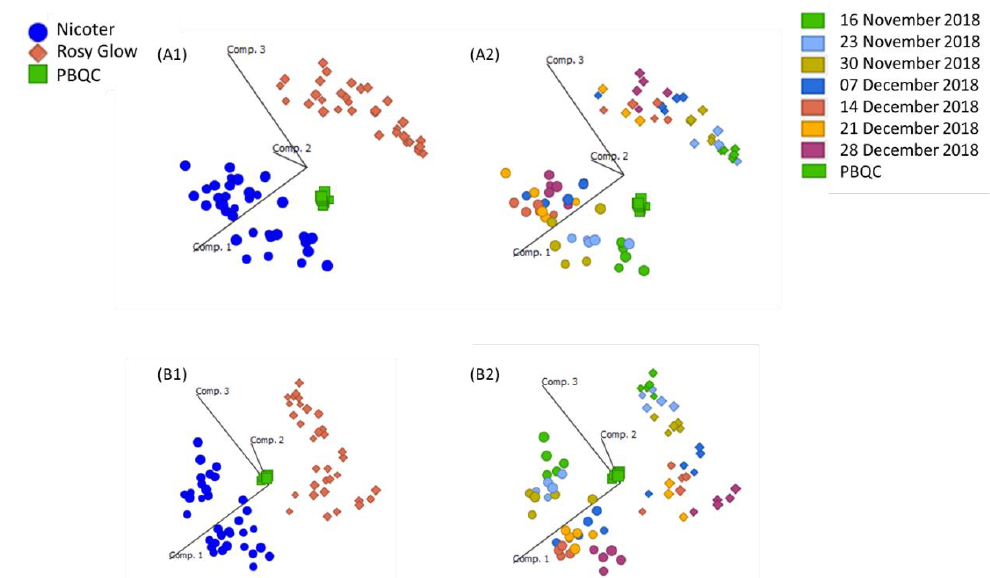
Figure 2. Principal component analysis (PCA) score plot showing ‘Nicoter’ ( n = 35) and ‘Rosy Glow’ ( n = 33) apple spur bud extracts evaluated on ( A ) ESI+ UHPLC-HRMS and ( B ) ESI- UHPLC-HRMS with a pooled biological quality control (PBQC) and categorised by ( A1 , B1 ) variety and ( A2 , B2 ) collection date.